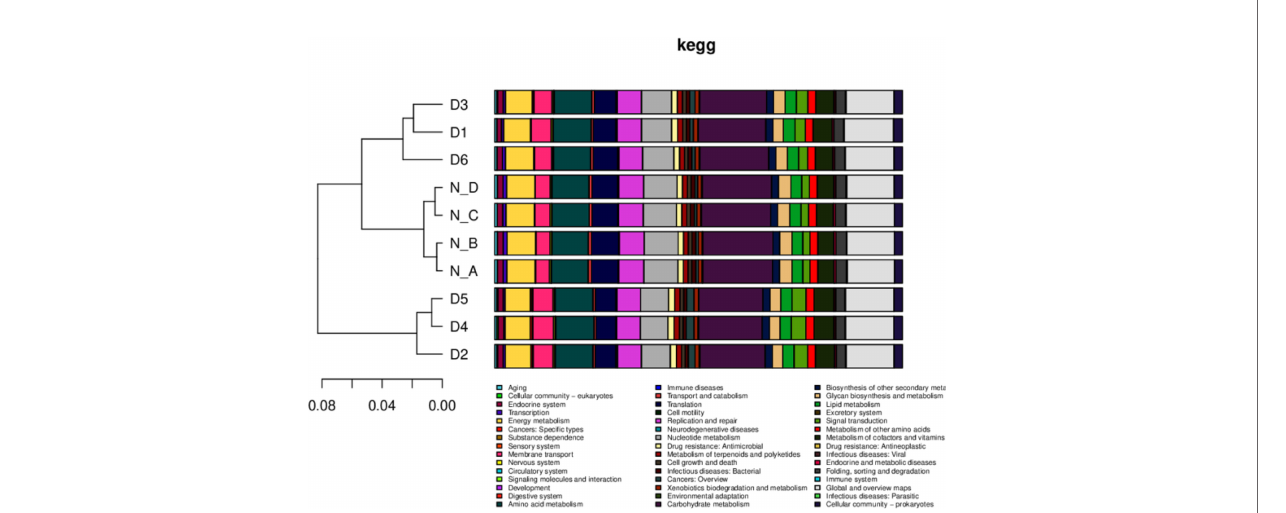
FIGURE 6 | The relative functional abundance analysis. KEGG. D1, D2, D3, D4, D5, and D6 represent the diarrheal samples; N_A, N_B, N_C, and N_D represent the normal